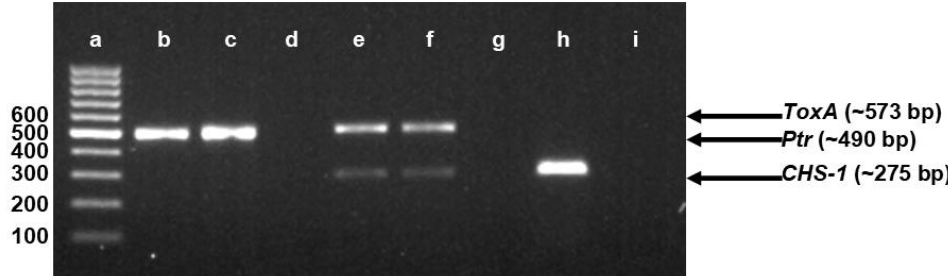
Figure 2. Example PCR amplification with primer sets specific for identification of Ptr isolates and ToxA and ToxB effector genes. Detection of effector genes in the Ptr population in Kazakhstan using multiplex PCR with specific primers ToxA (TA51F/TA52R) and ToxB (TB71F/TB60R) and the chitin synthase 1 gene ( CHS-1 ) as an internal control for the presence of fungal DNA. The reaction products are visualized on a 1.5% agarose gel stained with ethidium bromide. An isolate collected in 2018 was used as a positive control, representing Race 1. (a) DNA ladder (100 bp); (b) isolate KZ/Kt-19-10 ( Ptr ); (c) positive control ( Ptr ); (d) negative control (water); (e) isolate KZ/Kt-19-10 ( ToxA + CHS-1 ); (f) positive control ( ToxA + CHS-1 ); (g) negative control (water); (h) isolate KZ/Kt-19-10